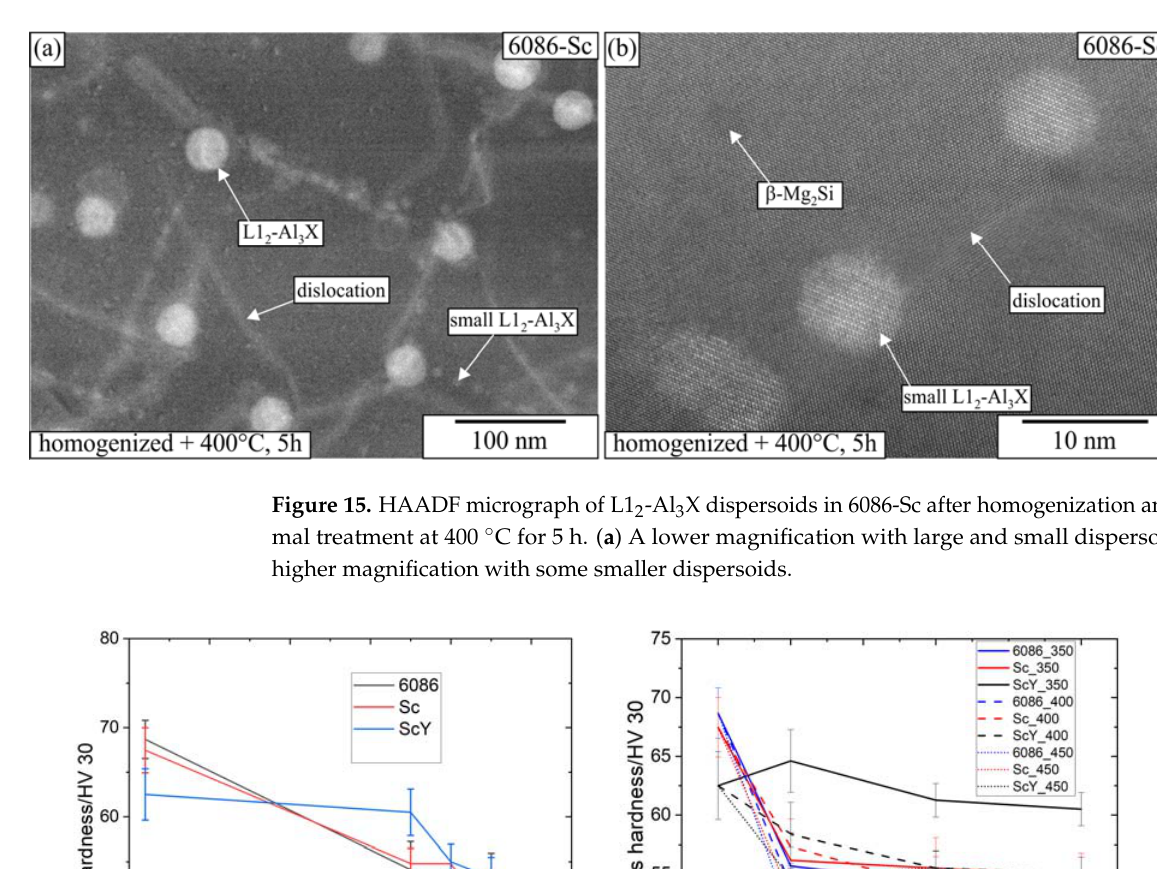
Figure 15. HAADF micrograph of L1 2 -Al 3 X dispersoids in 6086-Sc after homogenization and isothermal treatment at 400 °C for 5 h. ( a ) A lower magni fi cation with large and small dispersoids, ( b ) A higher magni fi cation with some smaller dispersoids.